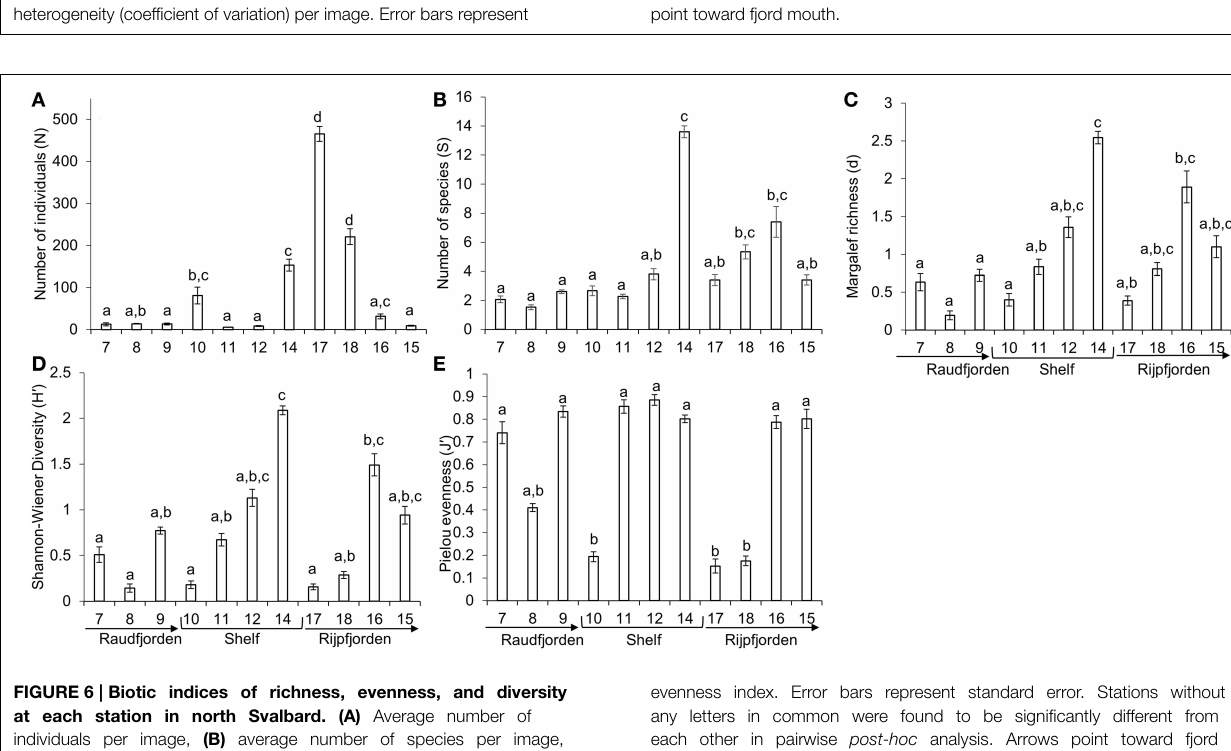
FIGURE 5 | Abiotic factors at each north Svalbard station. (A) Average percent hard substratum cover per image, (B) average stone size heterogeneity (coefficient of variation) per image. Error bars represent